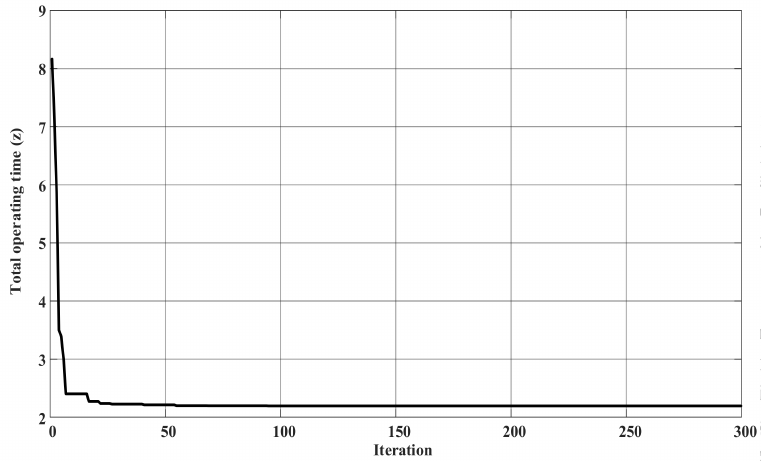
Figure 11. Convergence characteristic graph of the objective function z (31) for Case III.